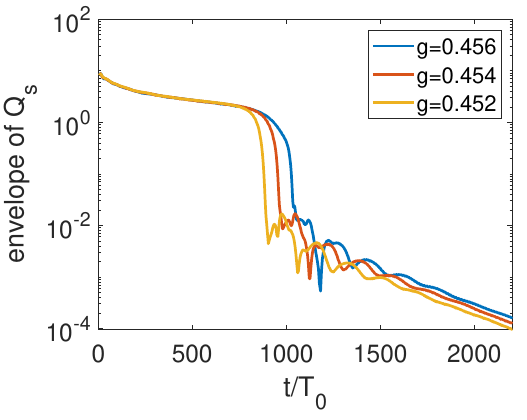
Figure 26. Charge plateau of a quadrupole CSQ. The other parameters are set to be d = 3 and ω = 0 . 84